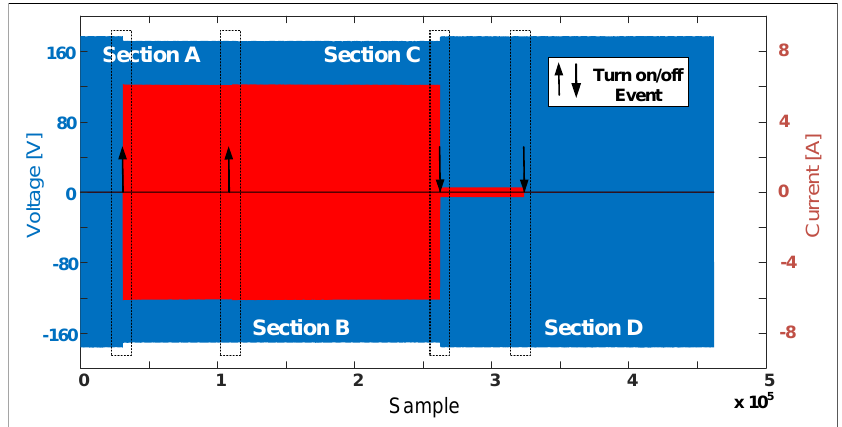
Figure 14. Jig acquisition of two loads: oil heater and LED lamp—trigger angle of 135